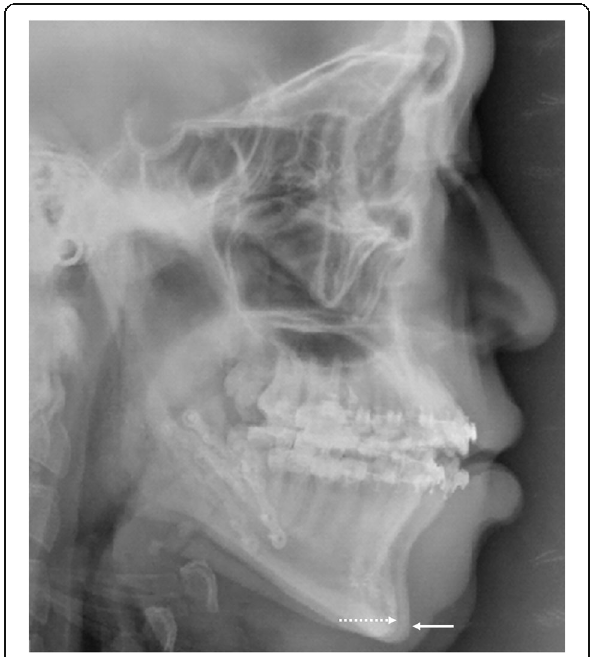
Fig. 4 An example of mandibular relapse after SFA. Pogonion position at the immediate postoperative mark (broken arrow), significantly moved forward after surgery with SFA (solid arrow) without any evidence of temporomandibular joint